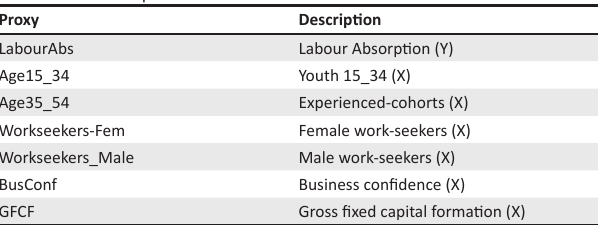
TABLE 1: Variable